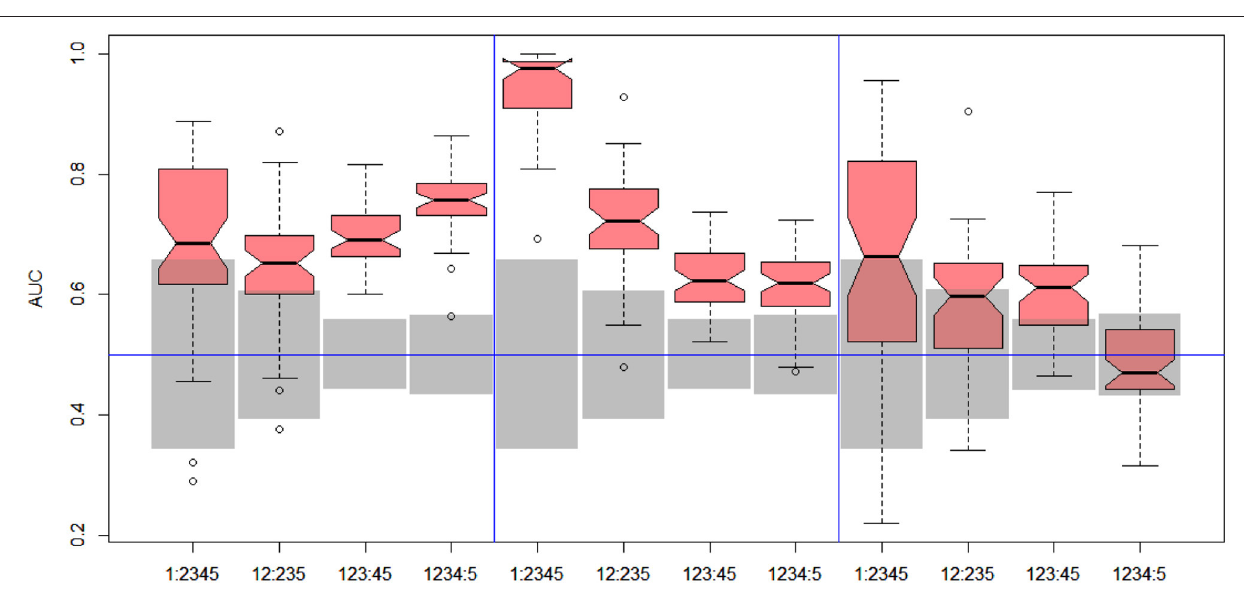
FIGURE 7 | DILI4 scanning results for MOLD, FAERS, and tox21. Gray boxes correspond to 95% confidence interval for the null